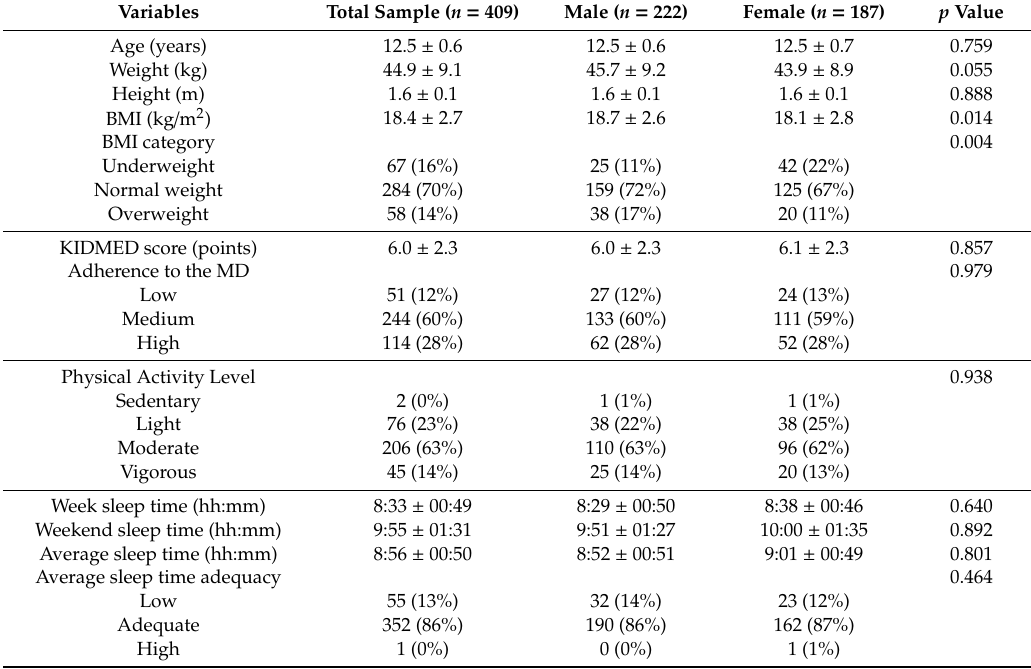
Table 1. Anthropometric measures and lifestyle data for the total samples and by